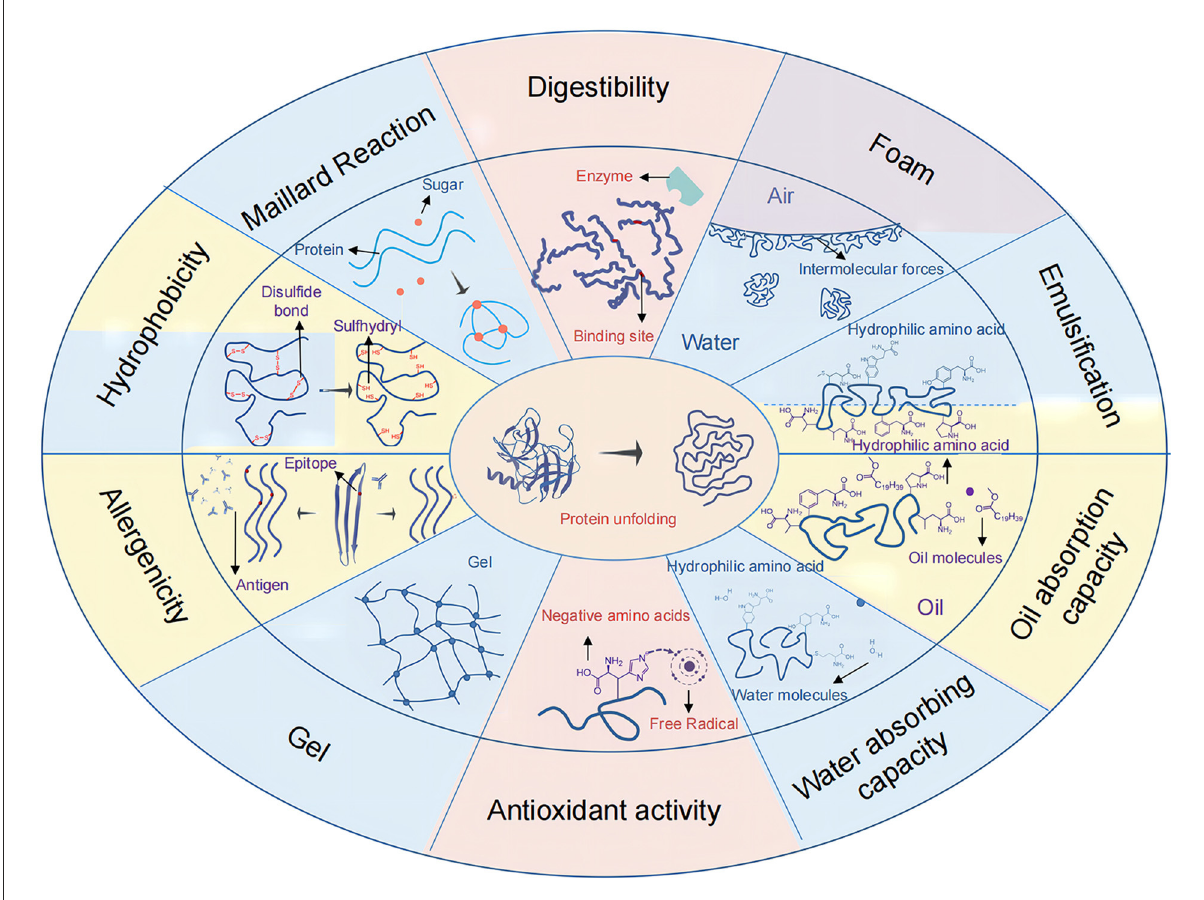
FIGURE9 Effect of microwave heating on protein structure and